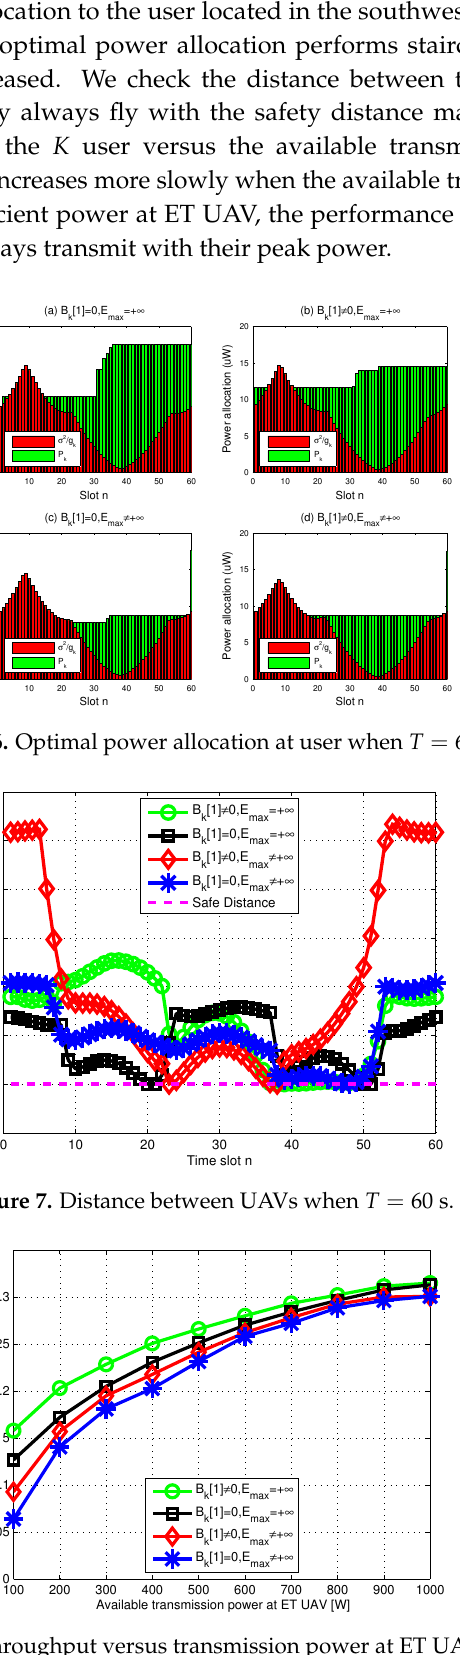
Figure 8. Minimum throughput versus transmission power at ET UAV when T = 60